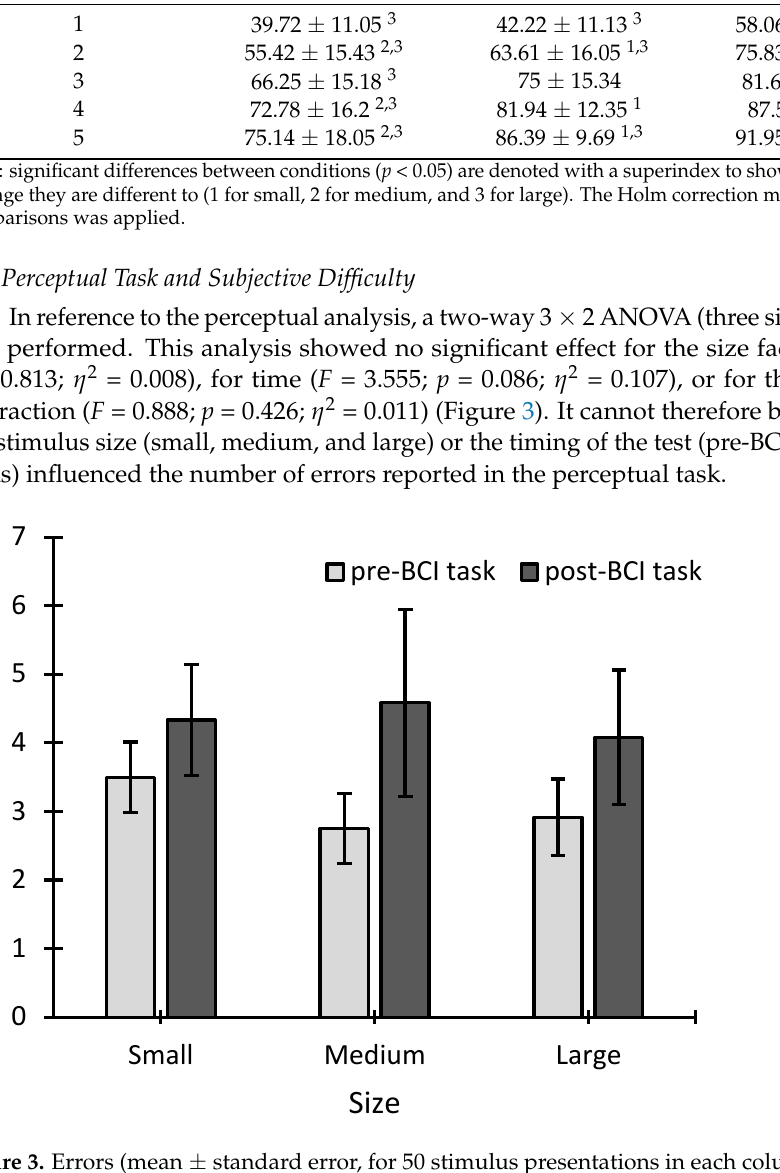
were found for small versus medium ( p < 0.001; d = 1.727) and large ( p < 0.001; d = 1.683) but not for medium versus large ( p = 1; d = − 0.044). The results clearly indicate that the small size was reported to be the most difficult for the participants in the BCI